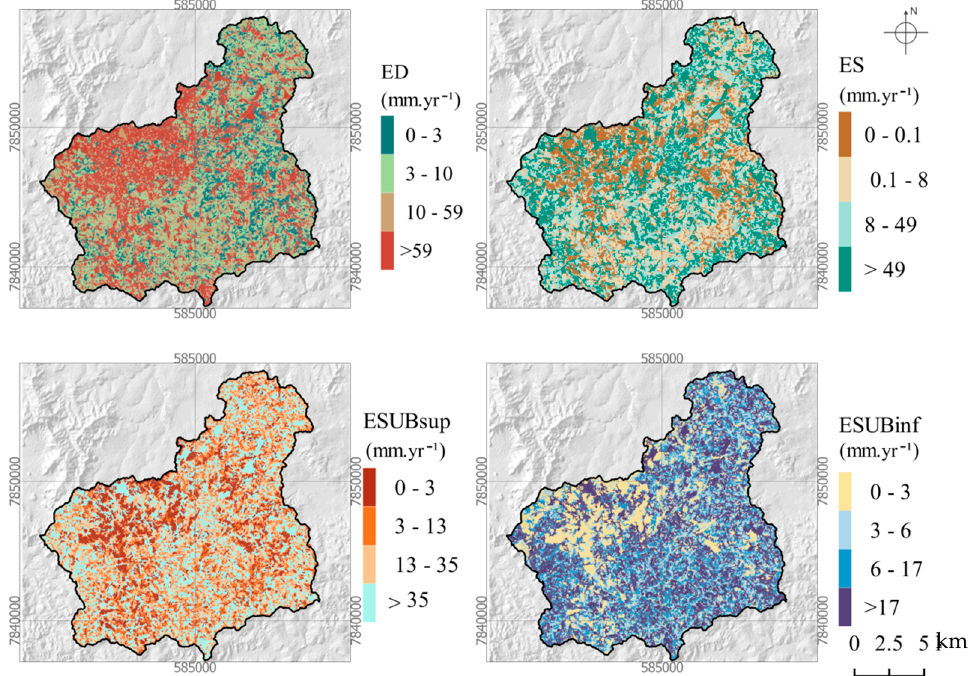
Figure 5. Spatial distribution of stream flow components estimated by the hydrological model. Symbols: ED—surface flow (overland flow due to sealing or saturation excess), ES—fast interflow (percolation within the upper soil layer); ESUBsup—fast baseflow (usually from the weathering part or fissures if existing); ESUPinf—base flow from base rock.